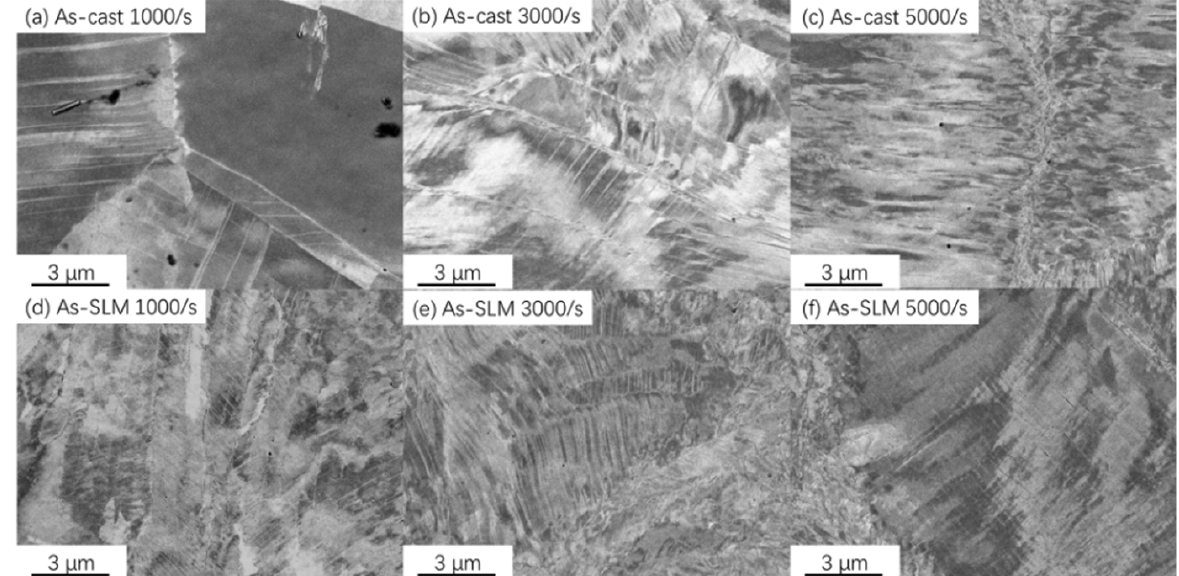
Figure 3. Microstructures of the deformed specimens. ( a – c ) 1000/s, 3000/s and 5000/s of the As-Cast specimens. ( d – f ) 1000/s, 3000/s and 5000/s of the As-Cast specimens.